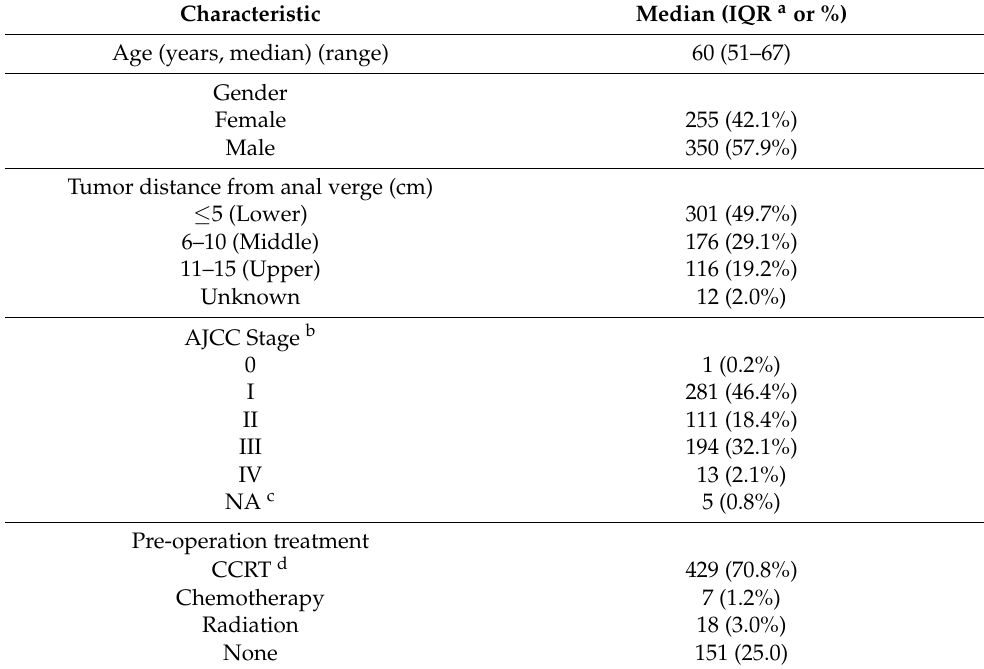
Table 1. Demographic and baseline characteristics of 605 patients with rectal cancer undergoing robotic-assisted rectal